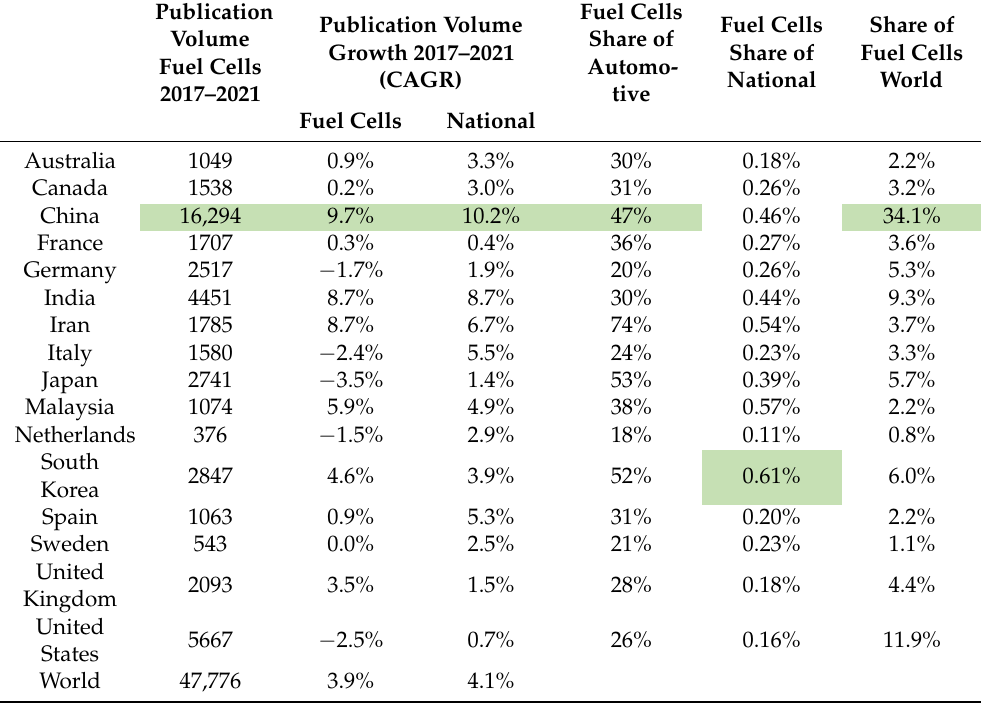
Table 4. Key indicators for fuel cell